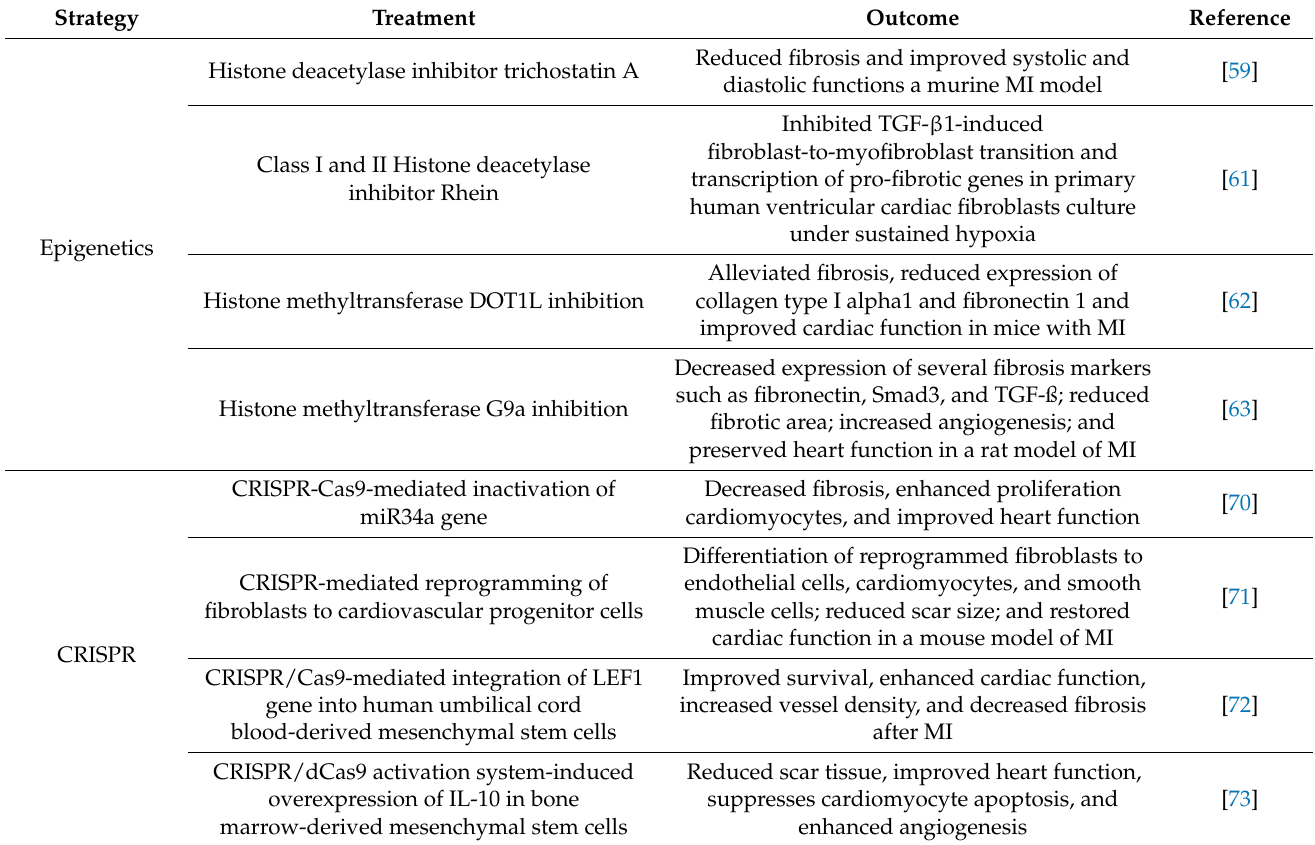
Table 1. The epigenetics and clustered regularly interspaced short palindromic repeats (CRISPR) used for the treatment of cardiac